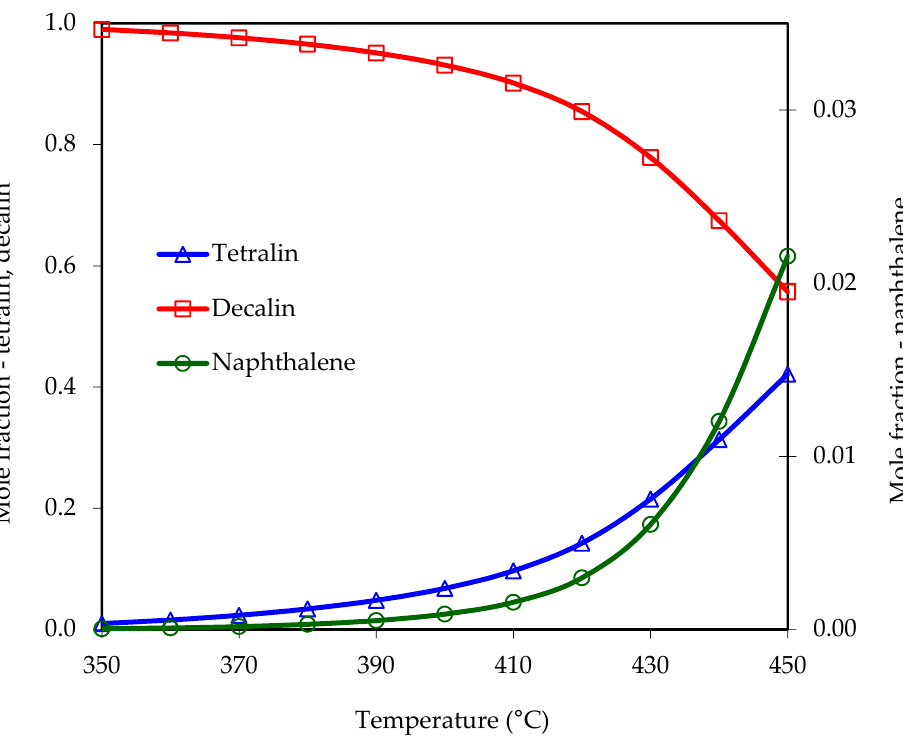
Figure 5. Equilibrium composition of a reaction mixture resulting upon hydrogenation of naphthalene (H 2 /feed ratio of 1000 L/L, 18 MPa).